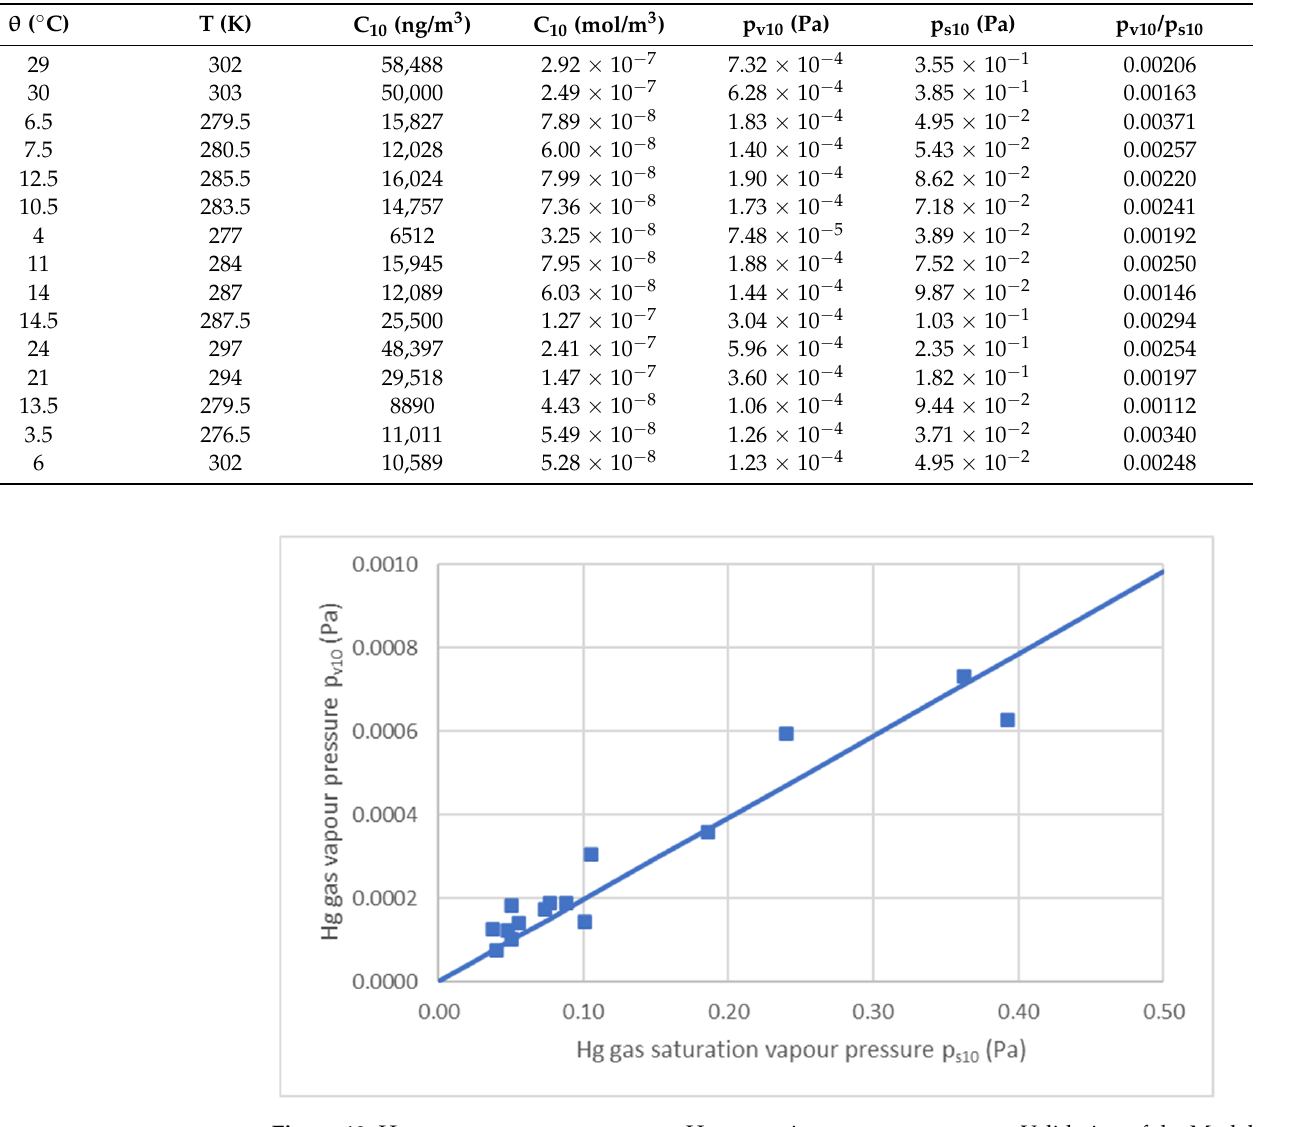
Figure 10. Hg vapor pressure p v10 versus Hg saturation vapor pressure p s10 Validation of the Model Based on the Laws of Liquid Evaporation.